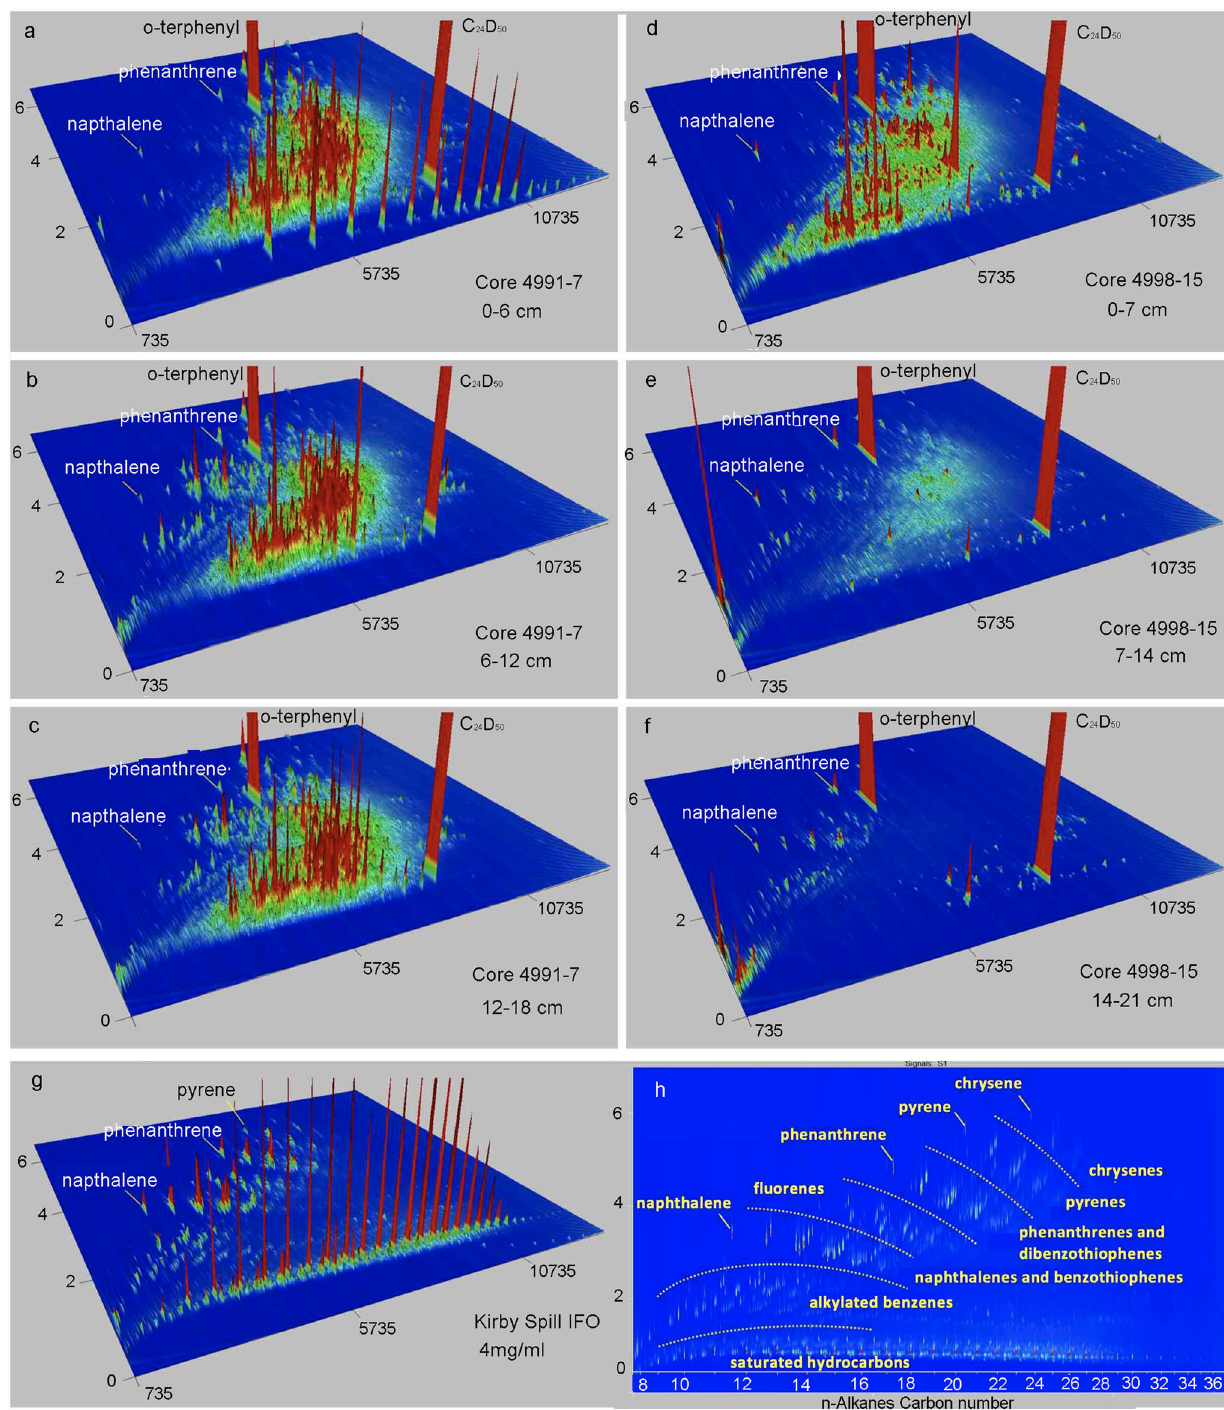
Fig. 2 GC×GC-HRT mountain plot of solvent extractable hydrocarbons from contrasting Guaymas cores. Temperate core 4991-7 is from Cathedral Hill (A-C, corresponding to ~0 – 5, ~5 – 14, and ~14 – 21 °C, respectively), hot core 4998-15 is from Marker 14 (D-F, corresponding to 0-~20 °C, ~20 – 52 °C, and ~52 – 74°C, respectively). a GC×GC-HRT mountain plot compares solvent extractable hydrocarbons from temperate core 4991-7 (mountain plots a – c ) and hot core 4998-15 (mountain plots d – f ). An annotated sample of intermediate fuel oil (IFO) is shown as a mountain plot in panel ( g ) and the data is presented in plan view in panel h highlighting the elution fairways of saturated hydrocarbons, alkylated benzenes, naphthalenes, and benzothiophenes, fl uorenes, phenanthrenes and dibenzothiophenes, pyrenes, and chrysenes. GC×GC-FID versions of chromatograms from core 4991-7 and core 4998-15 are shown in Supplementary Fig. S3. The large peaks in chromatograms a – f are = o -terphenyl and perdeuterated tetracosane internal standards added during the sample